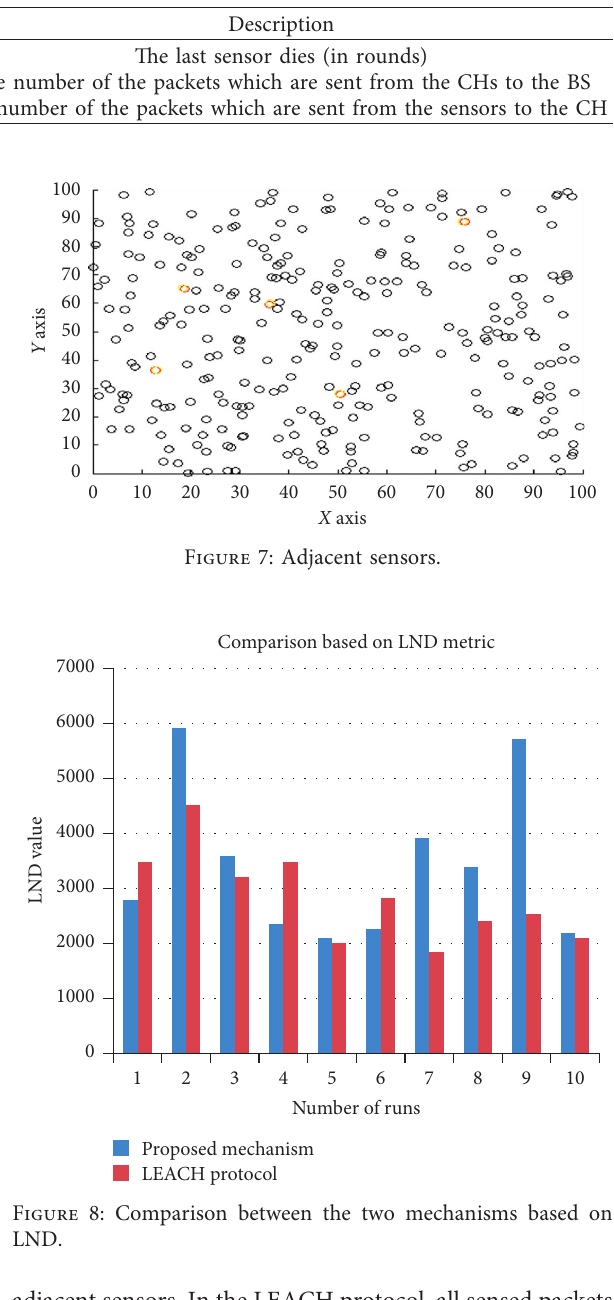
Table 1: Evaluation metrics.